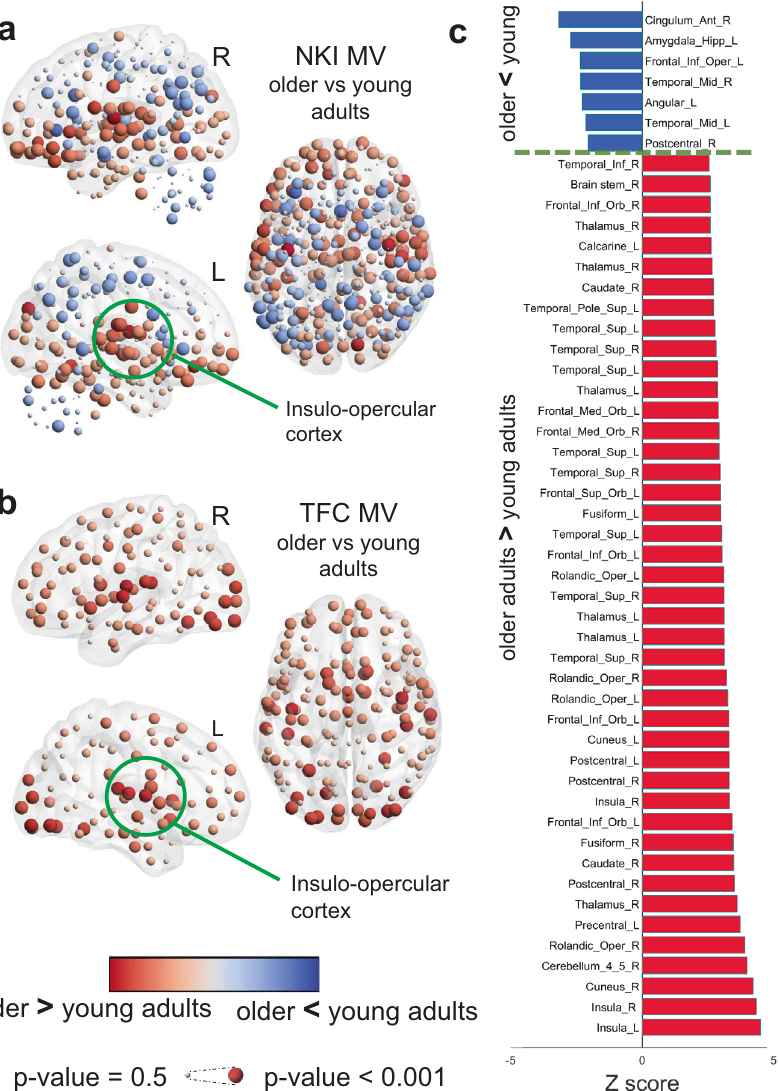
Fig. 4 Age effects of modular variability (MV). a Age differences in MV within the Nathan Kline Institute (NKI) cohort, older adults (OA) compared with young adults (YA). b Age differences in MV within The 1000 functional connectome (TFC) cohort OA compared with YA. c Signi fi cant brain regions from the NKI-MV comparison; corrected for multiple comparisons at p -value < 0.05. Differences were assessed with non-parametric permutations (5000) after regressing covariates of no interest. Regions ’ names are given using the Automatic Anatomical Labelling